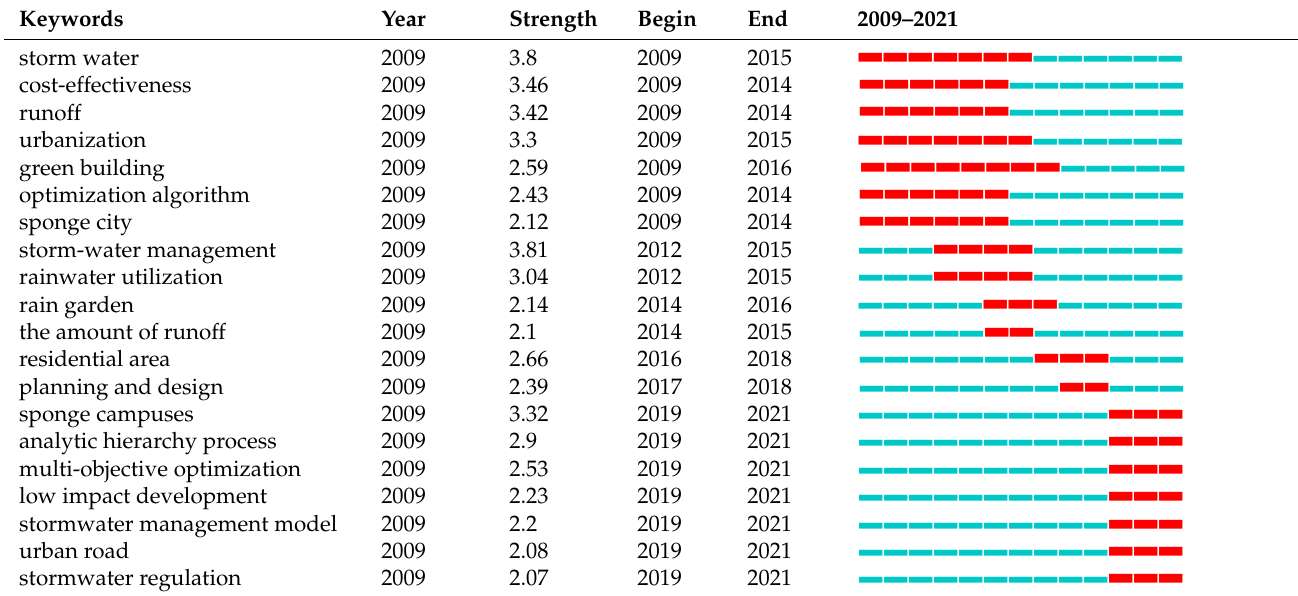
Table 9. The burst terms of publications according to the CNKI database.